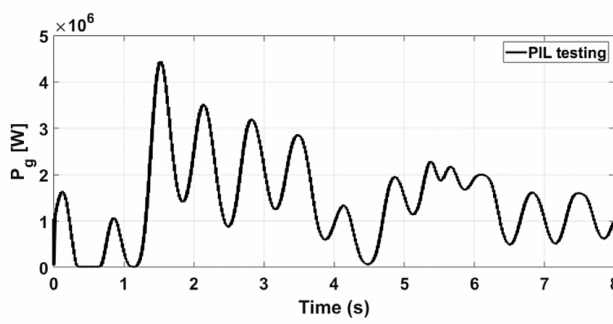
Figure 21. Experimental step.